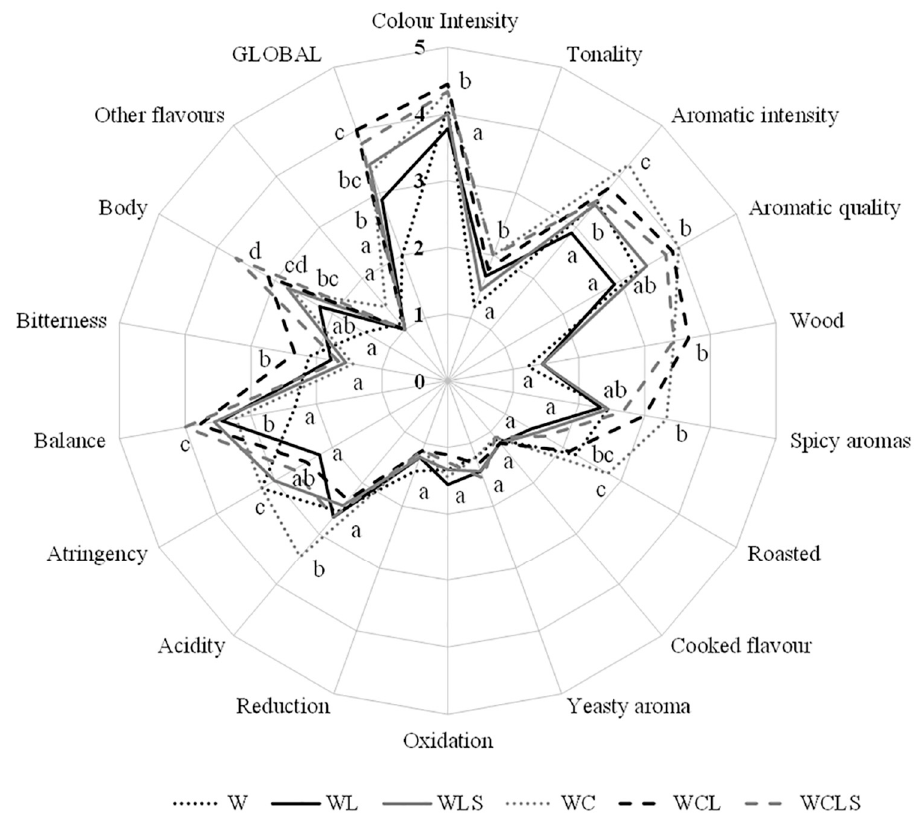
Figure 6. Sensory analysis carried out by a panel of nine experienced tasters. W—control wine; WL—wine with lees; WLS—wine with sonicated lees; WC—wine with oak chips; WCL—wine with lees and oak chips; WCLS—wine with sonicated lees and oak chips. Different letters in the same axis indicate values with statistical significant differences ( p < 0.05).